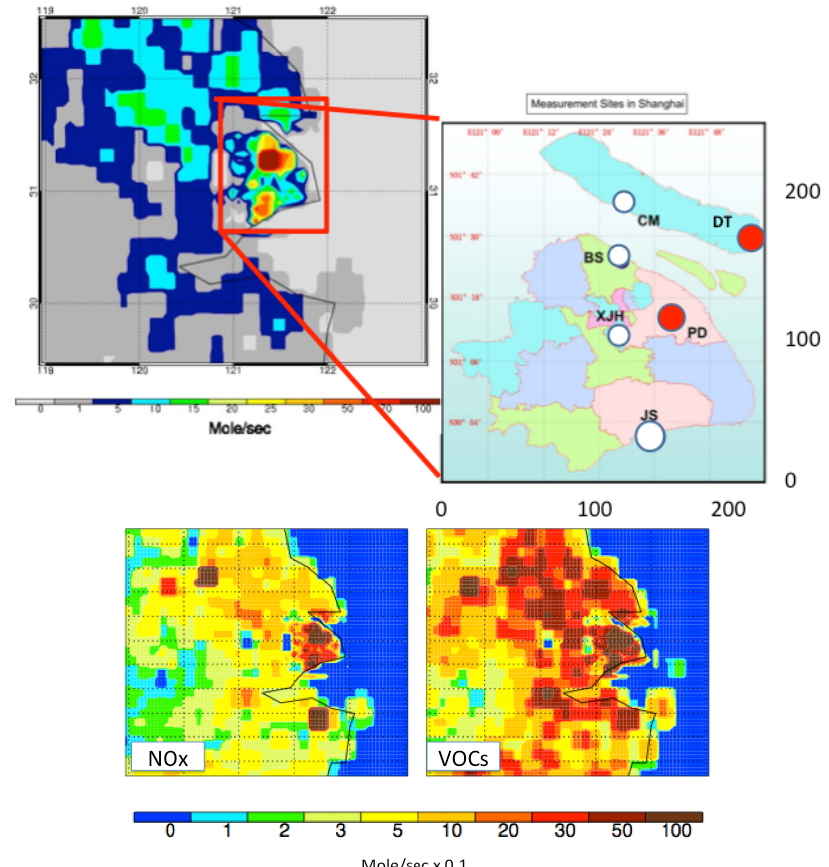
Fig. 1. The measurement sites (top panel) and the corresponding emission distribution of CO (bottom panel) in the Shanghai region. The small red points indicate the routine measurement sites operated by SMB, and the large red points show the 3 super sites during the field